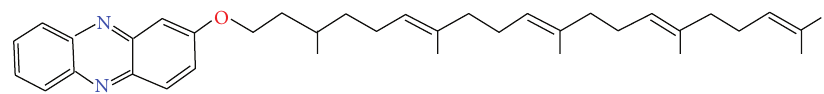
Figure 3: Chemical structure of methanophenazine, a phenazine observed only in